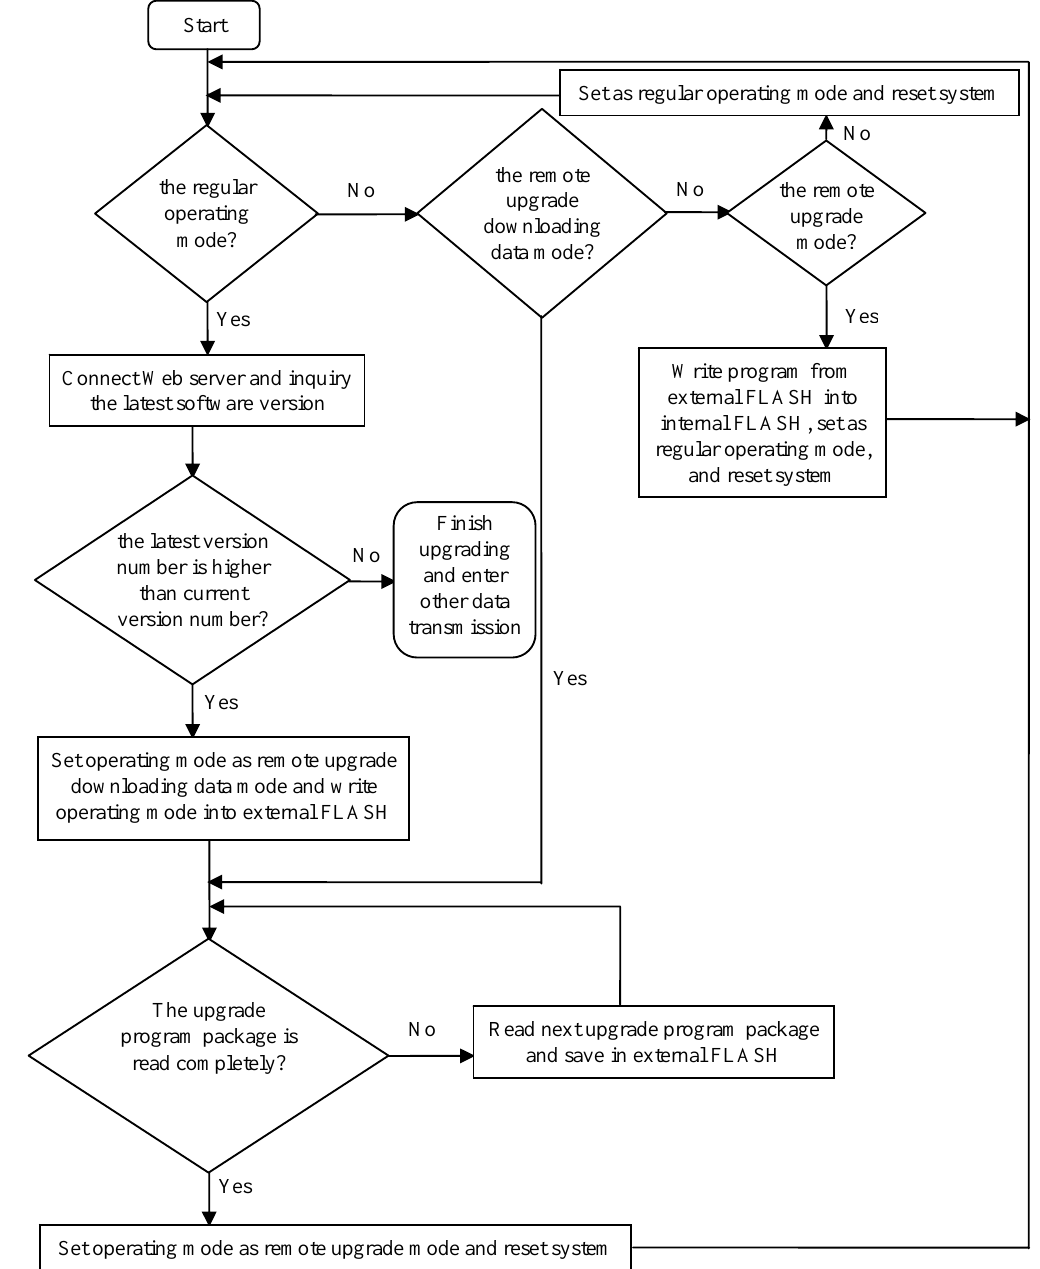
Figure 4. Flow chart of the remote upgrade